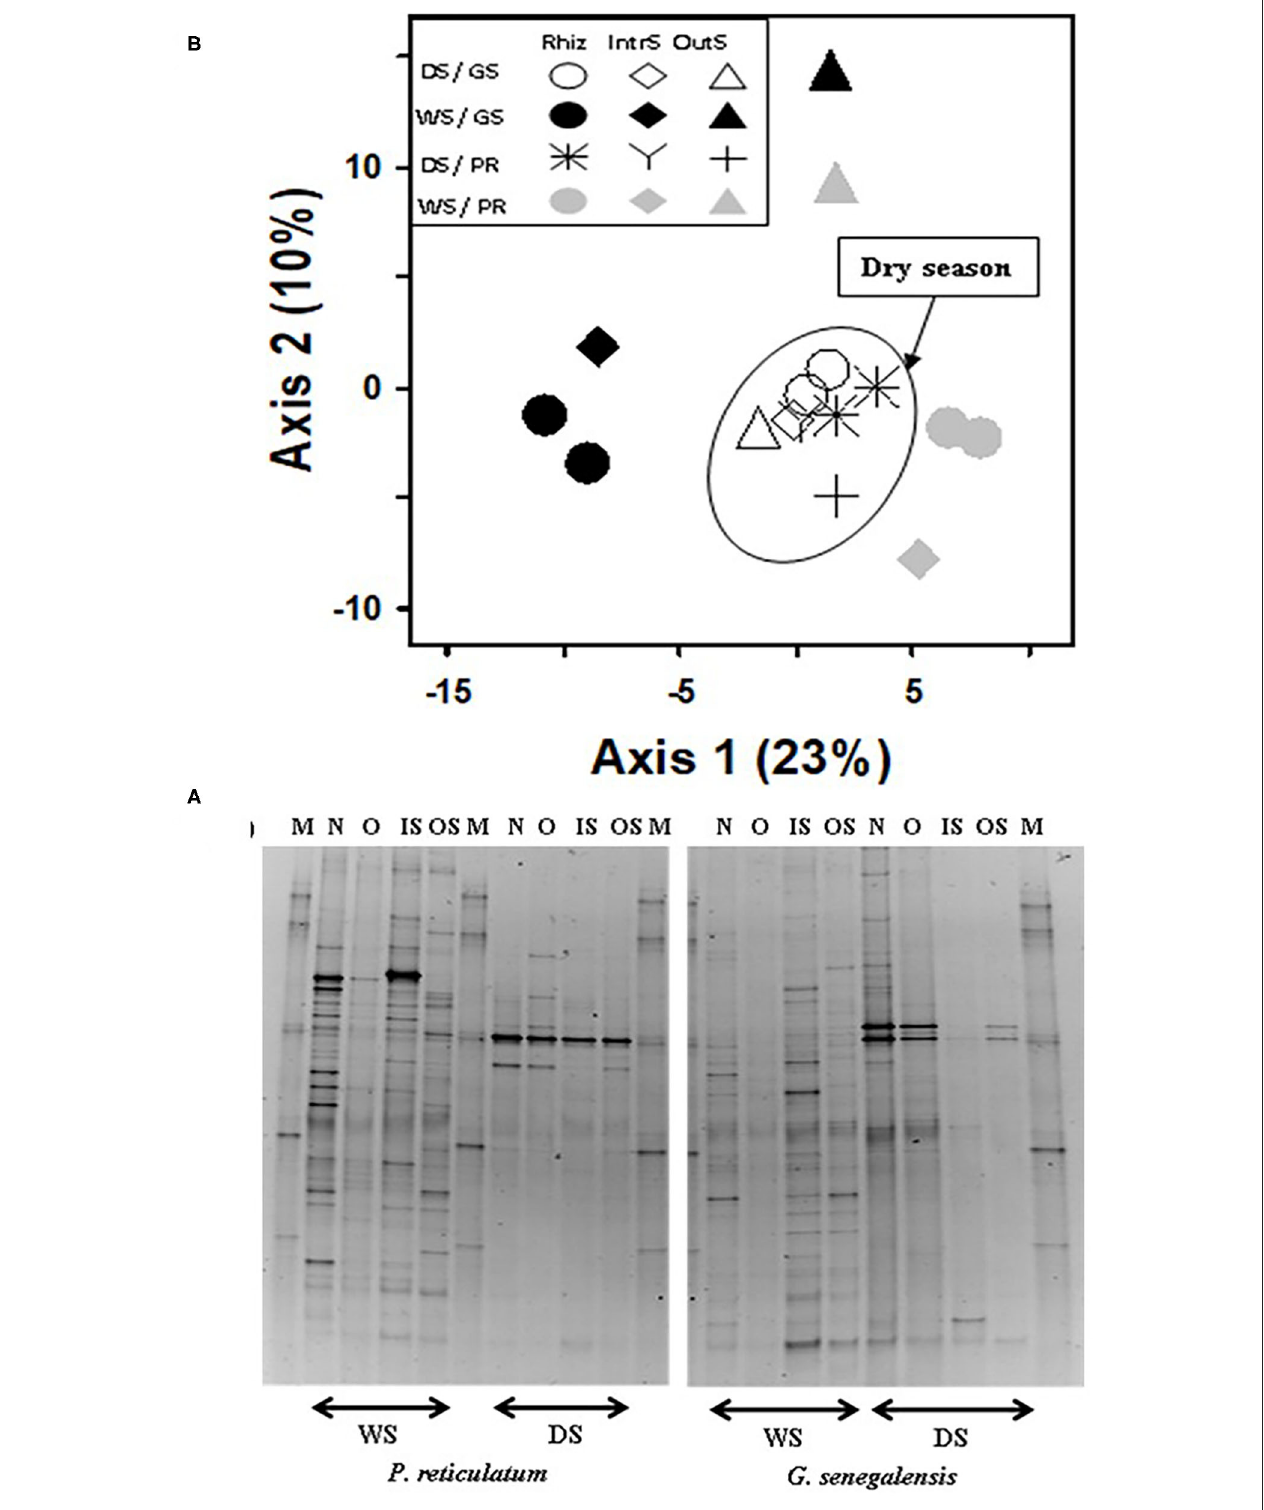
FIGURE 5 | (A) Fungal DGGE profile of 28S rDNA PCR product extracted from soil and (B) PCA ordination analysis of DGGE banding profiles. Samples are from the wet (WS) and dry season (DS) in two sites with G. senegalensis (GS) and P. reticulatum (PR) shrubs. In DGGE gel image M, marker; OS, outside the influence of shrub soil; IS, inter-root soil; O, old roots; and N, new roots. In PCA plot RhizS, shrub rhizosphere soil; IntrS, inter-root soil; and OutS, outside the influence of shrub soil.